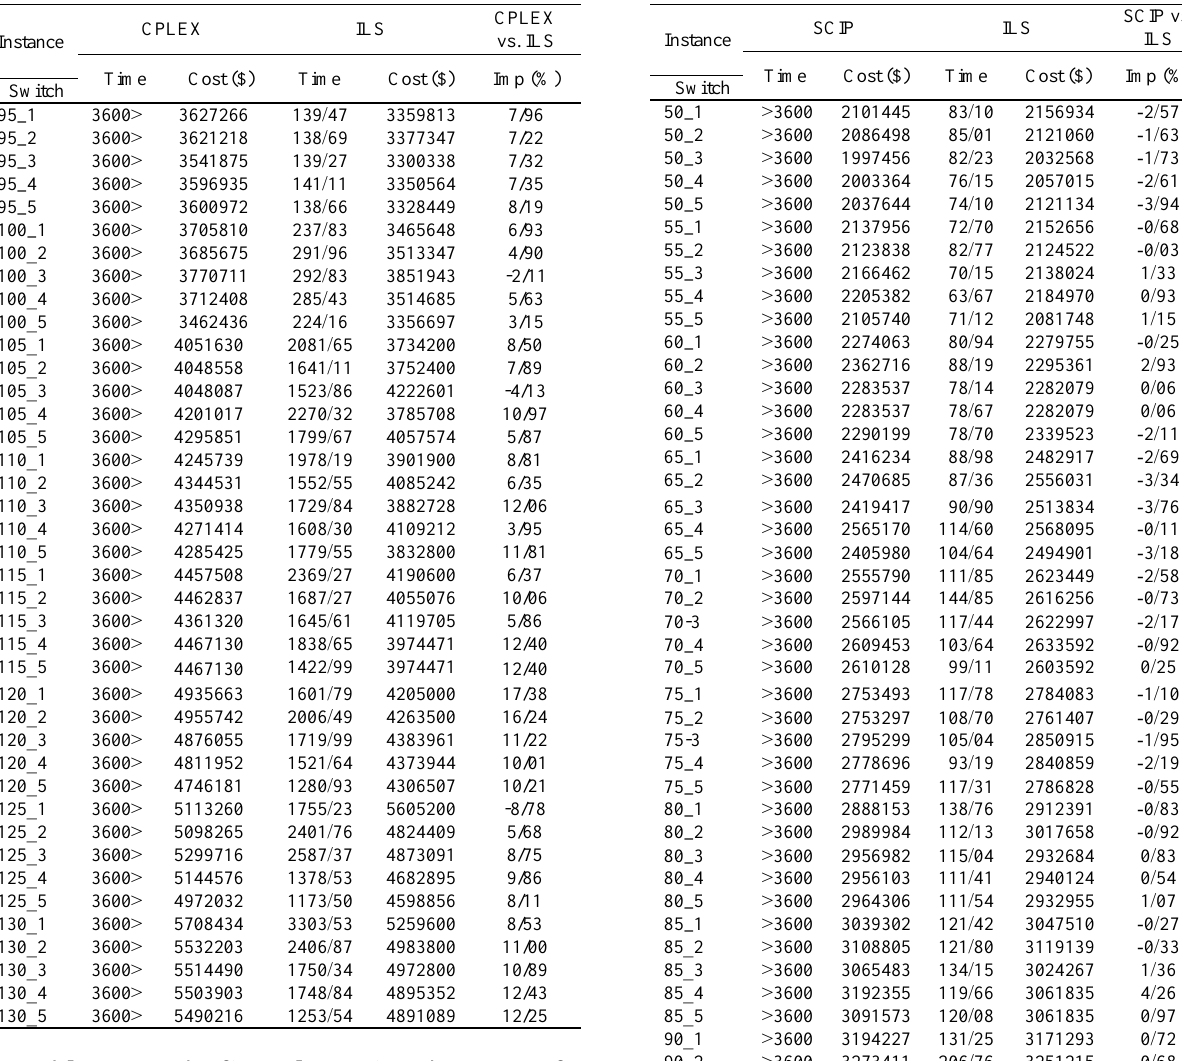
Table 5. Results obtained from ILS algorithm and SCIP on instances of large